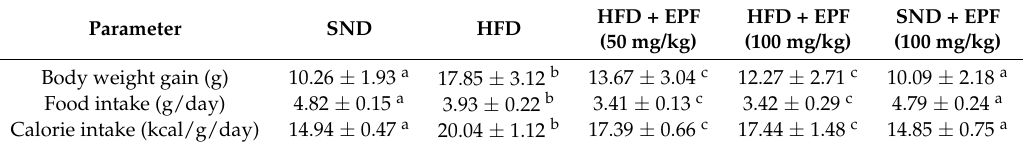
Table 2. Effect of EPF on the body weight gain, food intake and calorie intake.